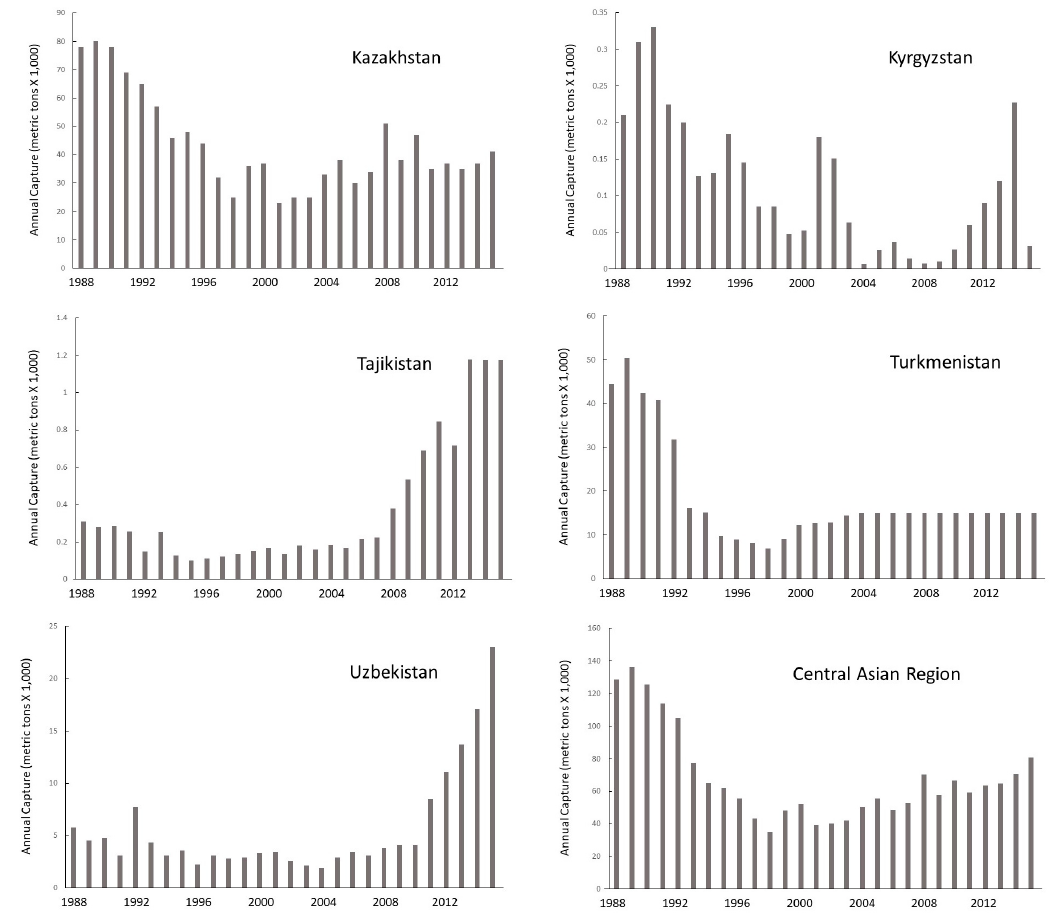
Figure 2. Estimated annual fish capture (in metric tons) in the five individual countries of Central Asia and the region as a whole between 1988 and 2015 (Sources: www.fao.org and www.worldbank.org/indicator/ER.FSH.PROD.MT).